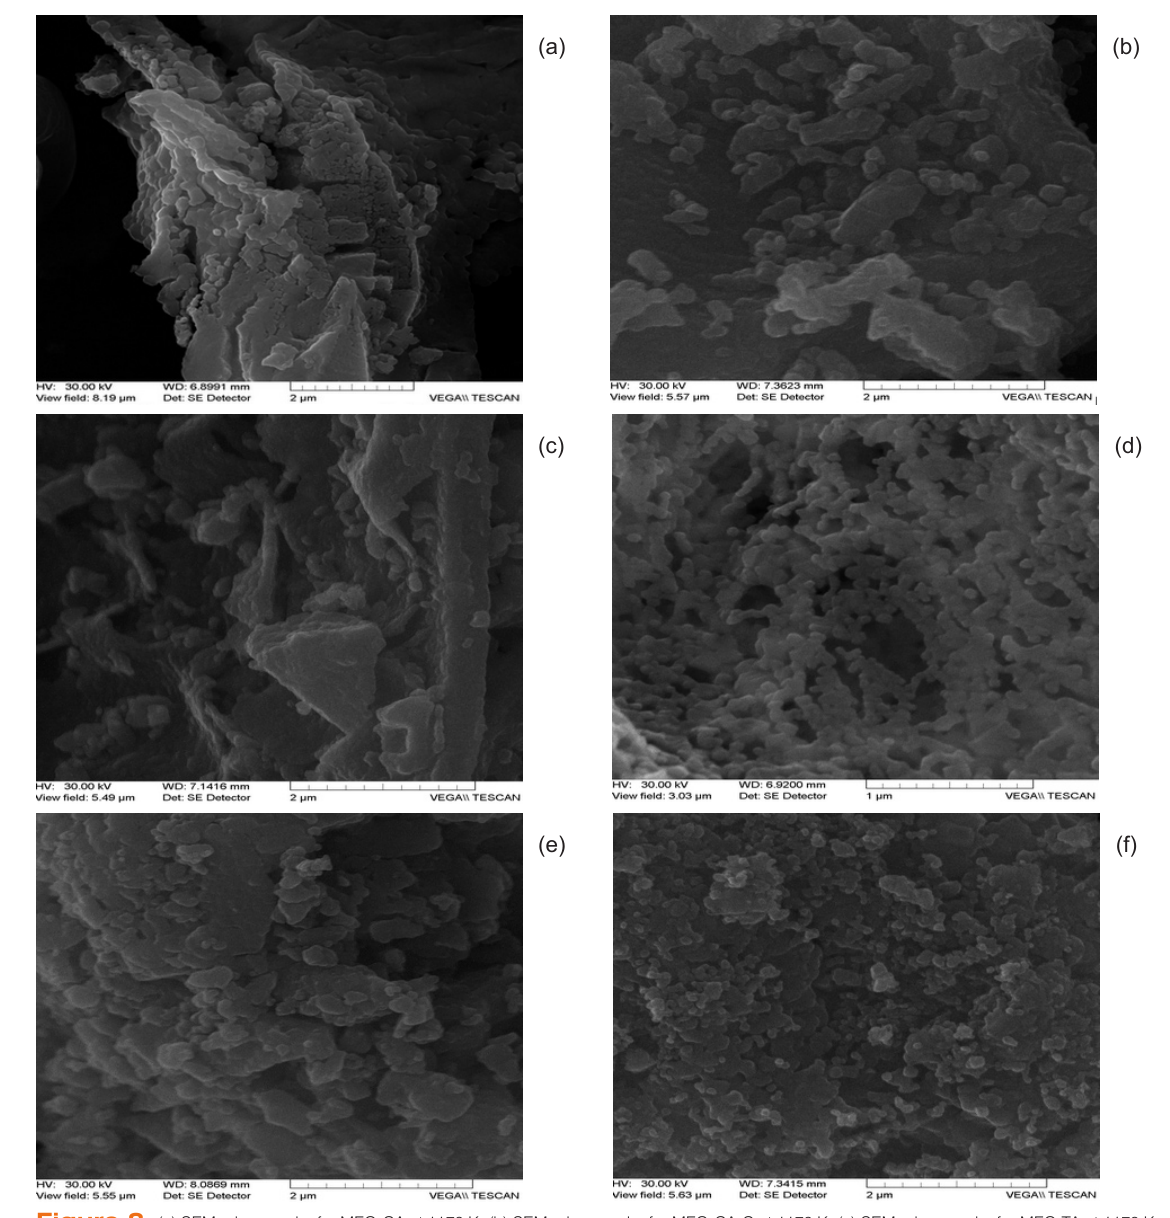
Figure 8. (a) SEM micrography for MFO-CA at 1173 K; (b) SEM micrography for MFO-CA-C at 1173 K; (c) SEM micrography for MFO-TA at 1173 K; (d) SEM micrography for MFO-Gly at 1173 K; (e) SEM micrography for MFO-HA at 1173 K; (f) SEM micrography for MFO-U at 1173